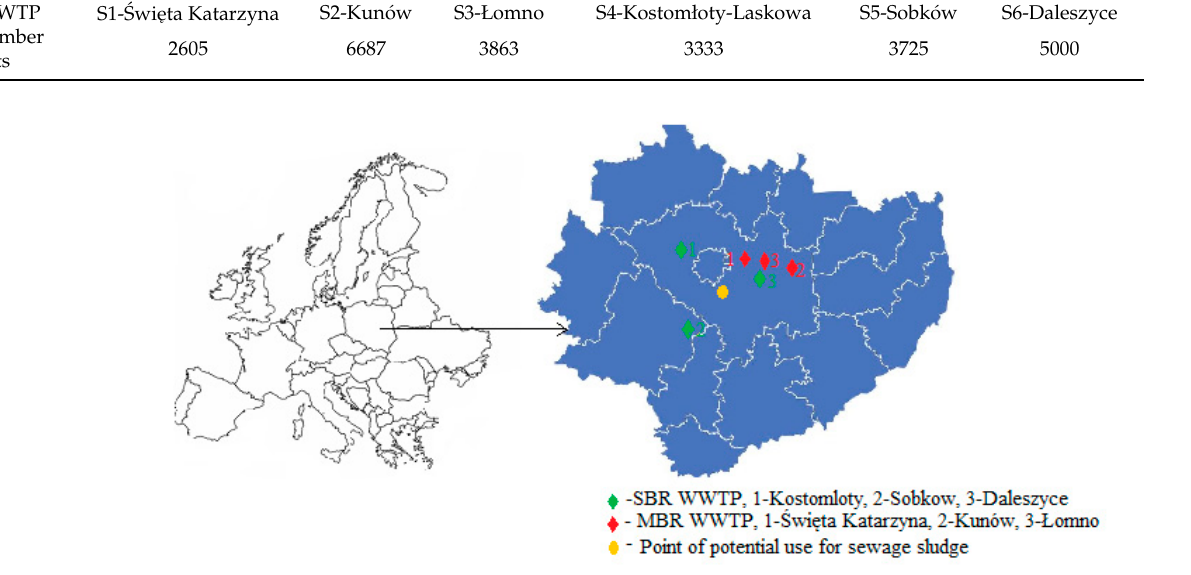
Figure 2. Location of wastewater treatment plants (own